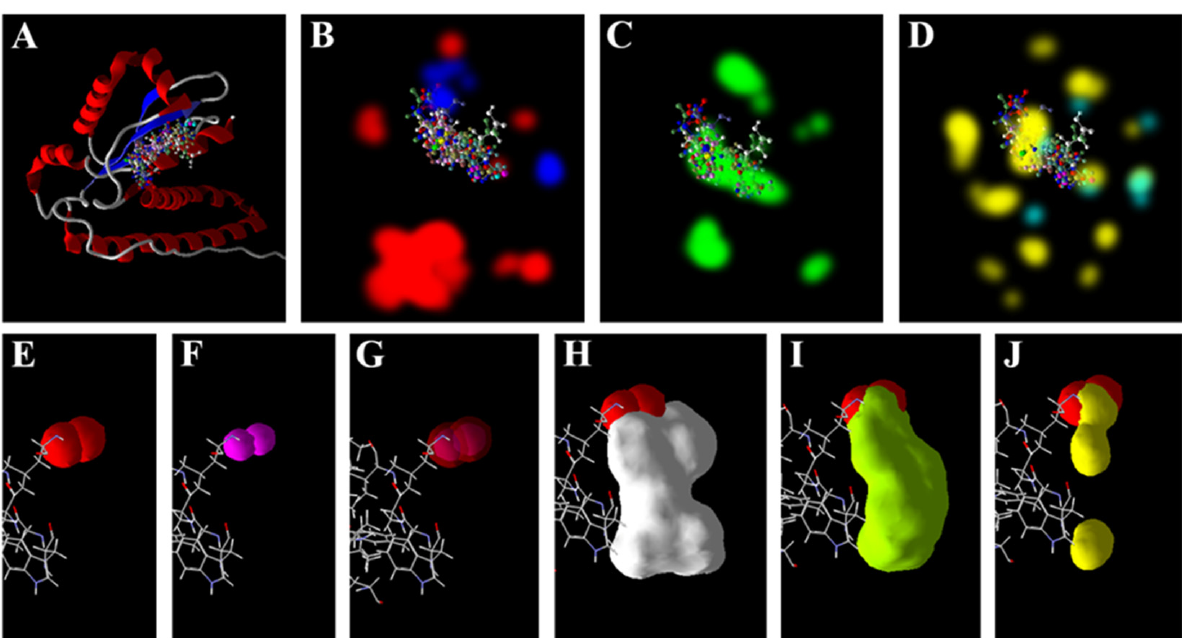
Figure 1. Docking poses and interactions of Mn-SOD with different ligands. ( A ) Docked poses of all ligands at the cavity; surfaces of the receptor favoring different interactions: electrostatic ( B ); stearic ( C ) and hydrogen bond ( D ). The electrostatic surfaces of As 3+ ( E ); Zn 2+ ( F ); and overlapped surfaces of As 3+ and Zn 2+ ( G ), As 3+ and five poses of GSH ( H ); As 3+ and ascorbic acid ( I ), and As 3+ and superoxide radicals ( J ). Poses and surfaces were developed using MVD.